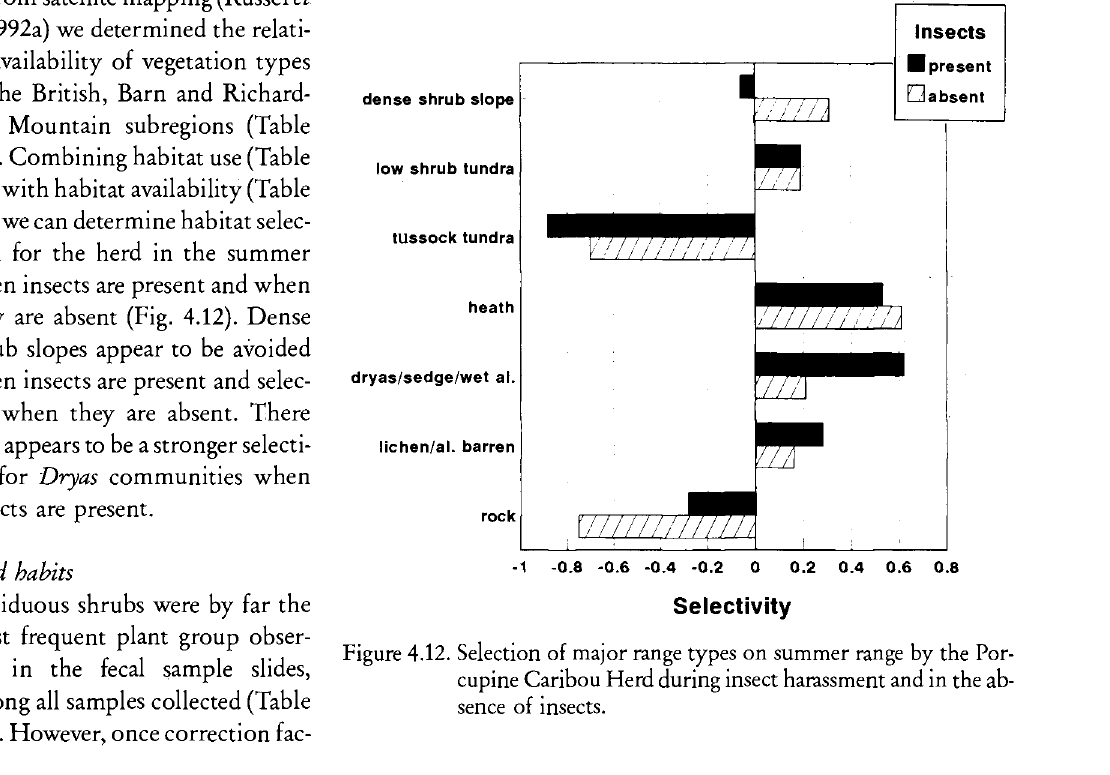
Table 4.8. Proportion (%) of fragments from different types of plants in the feces of caribou from the Porcupine Caribou Herd in July 1984. The numbers in parenthesis represent an estimate of the composition of the diet of standard correction factors to the data from fecal analysis. (See Methods).